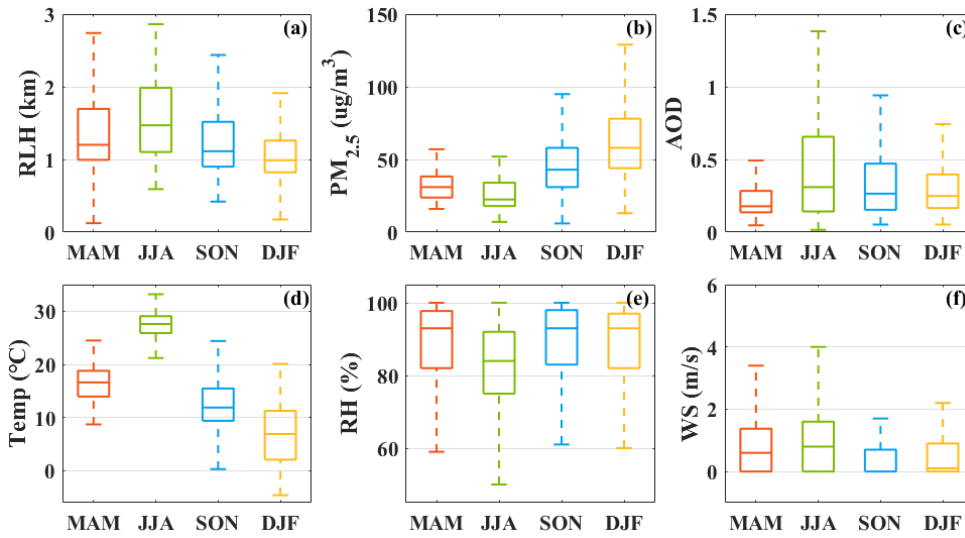
Figure 4. Seasonal distribution of ( a ) RLH; ( b ) PM 2.5 ; ( c ) AOD; ( d ) Temp; ( e ) RH; and ( f ) WS, from January 2017 to December 2019. The middle horizontal line of each bin represents the median value of each part, whereas the upper and lower ends of the box represent 25% and 75%, respectively, and the top and bottom of the dotted line represent 5% and 95%, respectively.